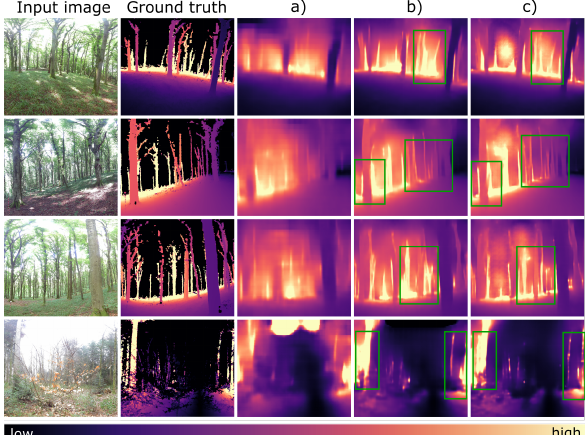
Figure 4. Predicted depth maps computed using our method with a) 100, b) 500, and c) 1000 input depth samples. The differences between a) and b) are easily noticeable. The green boxes show the more subtle differences between b) and